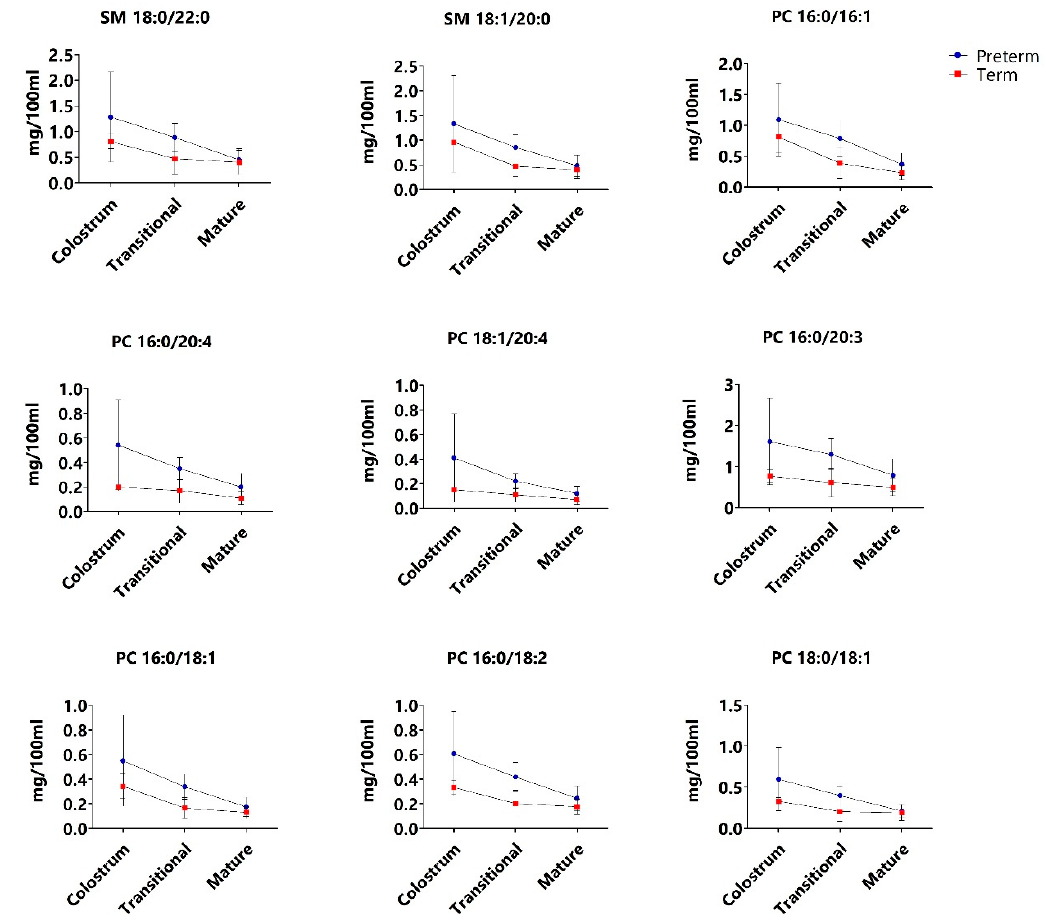
Figure 3. Concentration (mg/100 mL) of phosphatidylcholine (PC) and sphingomyelin (SM) species in preterm (blue circle) and term (red square) milk in colostrum (<5 days), transitional milk ( ≥ 5 days and ≤ 2 weeks) and mature milk (>2 weeks and ≤ 15 weeks).